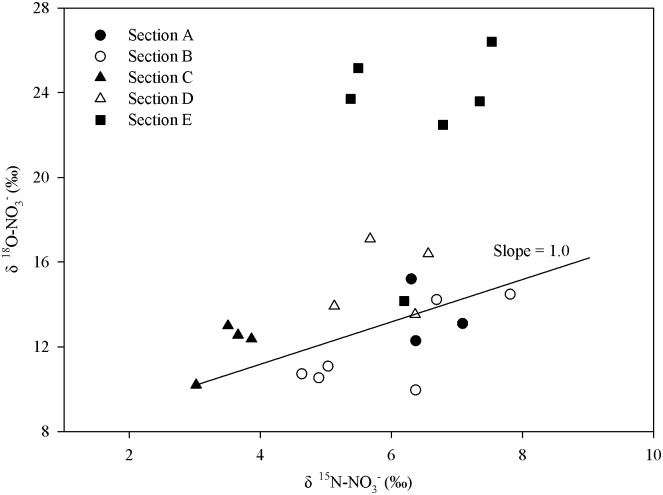
The range of δ15N-NO3- and δ18O-NO3- values measured in the bottom waters of the NSCS.